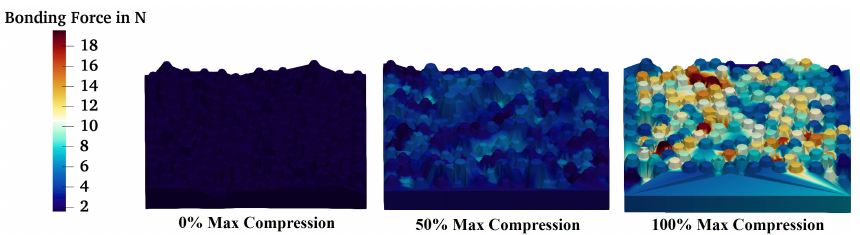
Figure 41. Grit 80 surface topography with bonding force at 0%, 50%, and 100% maximum compression.